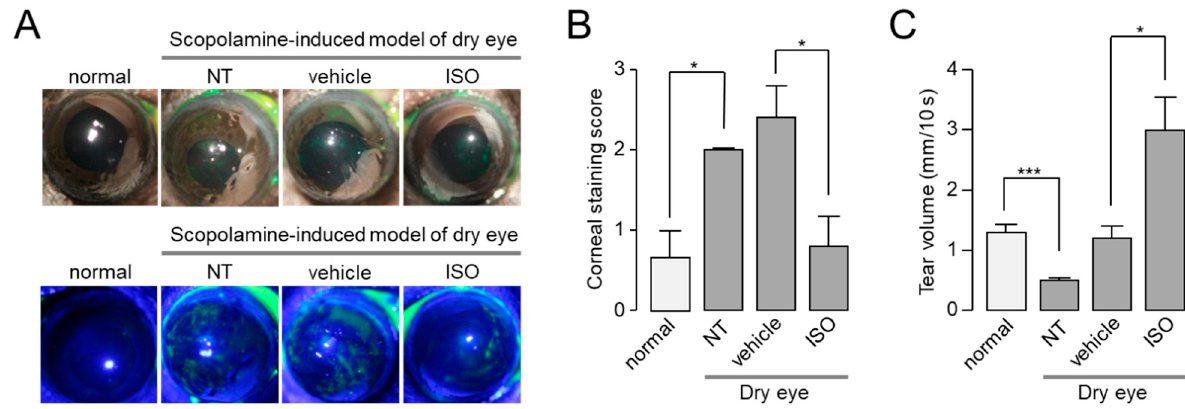
Figure 6. Isorhamnetin reduced ocular surface damage and increased tear fluid volume in a scopolamine-induced dry eye mouse model. ( A ) Representative photographs of mouse eyes (top) and corneal fluorescein staining images of normal and dry eye mice (bottom). Vehicle and isorhamnetin were treated three times a day for 10 days. ( B ) Degree of corneal epithelial disruption of each case measured by fluorescein staining on a five-point scale (mean ± S.E., n = 5). ( C ) Basal tear volume of each case measured with phenol red thread tear test (mean ± S.E., n = 5). NT, not treated. * p < 0.05, *** p < 0.001.